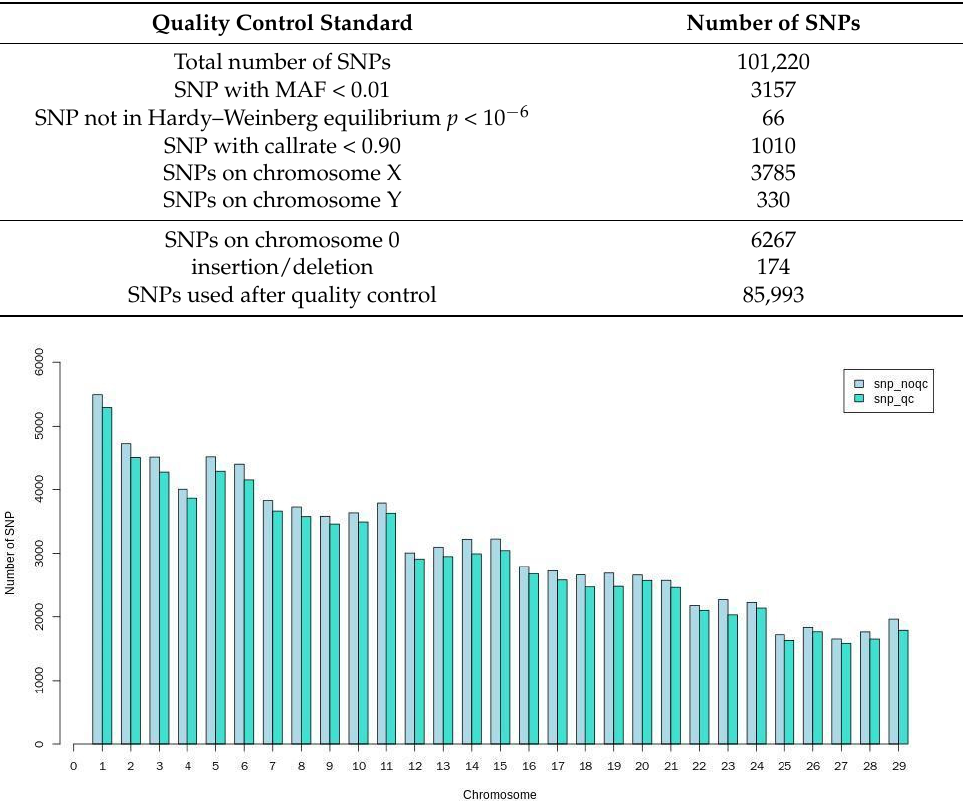
Figure 2. Distribution of SNPs on each chromosome before and after quality control. Note: the abscissa indicates the chromosome number, and the ordinate indicates the number of SNPs. Table 1. Statistical Results of SNP Quality Control.